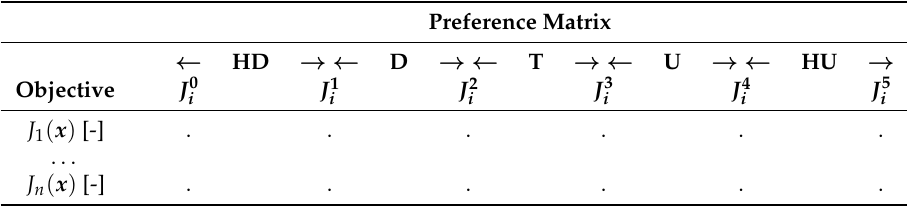
Table 2. Preference matrix M. Five preference ranges have been defined: highly desirable (HD), desirable (D), tolerable (T) undesirable (U) and highly undesirable (HU).